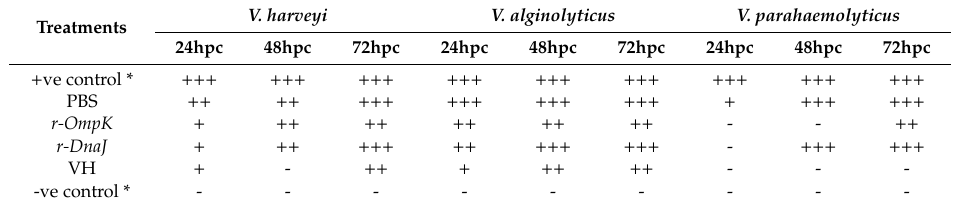
Table 6. Semi-quantitative PCR detected variable amount of V. harveyi , V. parahaemolyticus , and V. alginolyticus from the seawater samples of challenged